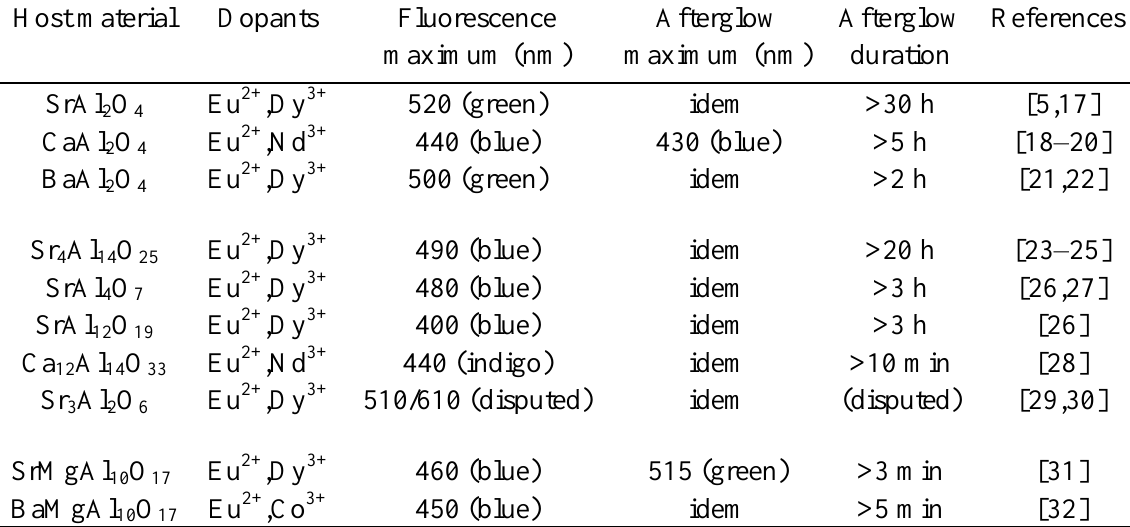
O :Eu 2+ ,Dy 3+ . (Reprinted with 2 4